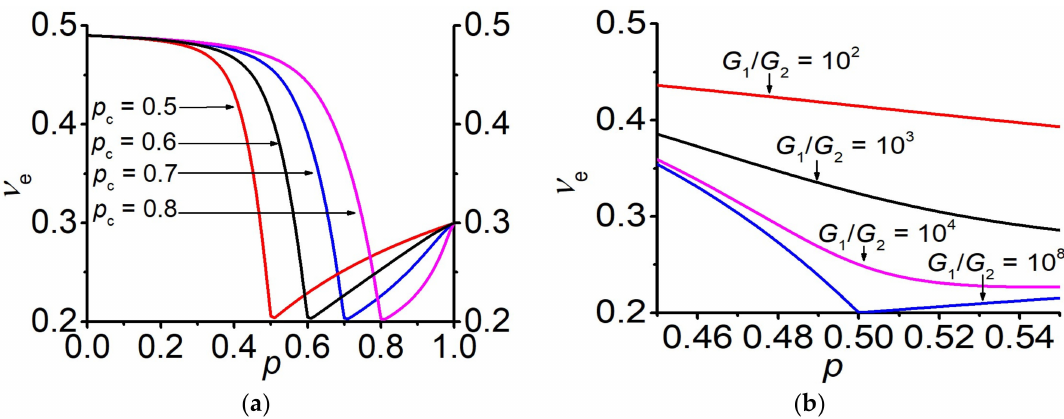
Figure 6. Concentration dependences of the e ff ective Poisson’s ratio ν e . ( a ) Variation of the percolation threshold. G 1 = 10 11 Pa, ν 1 = 0.3, G 2 = 10 5 Pa, ν 2 = 0.49; ( b ) Variation of the ratio G 1 / G 2 at p c = 1 / 2 . ν = 0.3, ν = 2 1